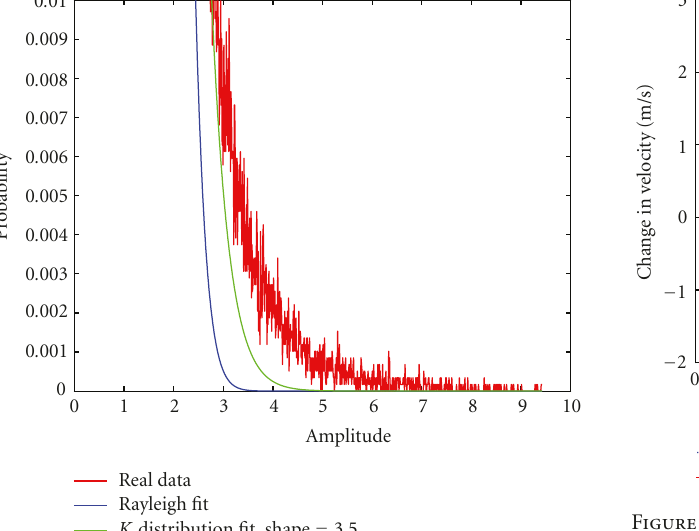
Figure 3: Close up of Figure 2 on high-amplitude tail of distribu- tion.